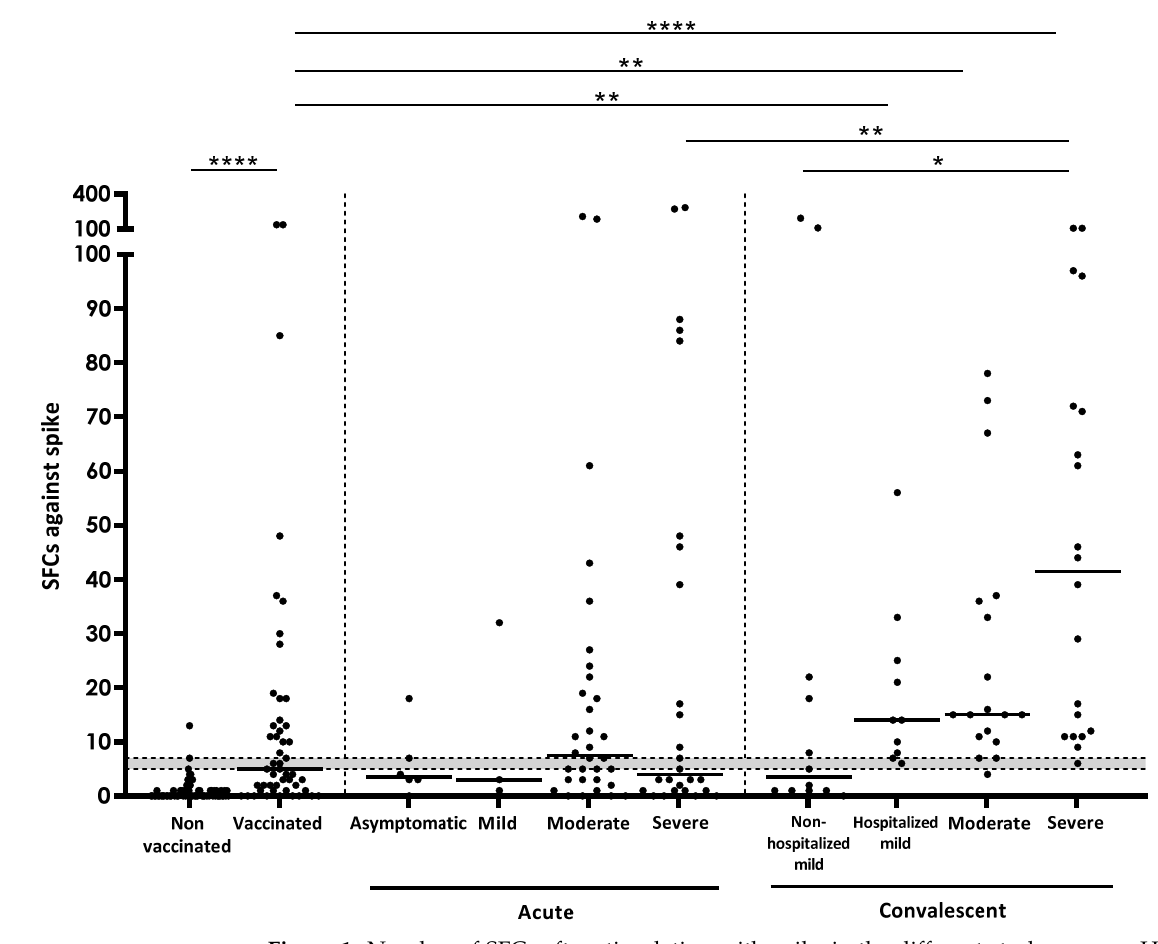
Figure 1. Number of SFCs after stimulation with spike in the different study groups. Horizontal lines represent medians. Grey area shows borderline results. Differences between conditions were calculated using the two-tailed Mann-Whitney U test. p is considered significant when <0.05 (* <0.05, ** <0.01, and **** < 0.0001).